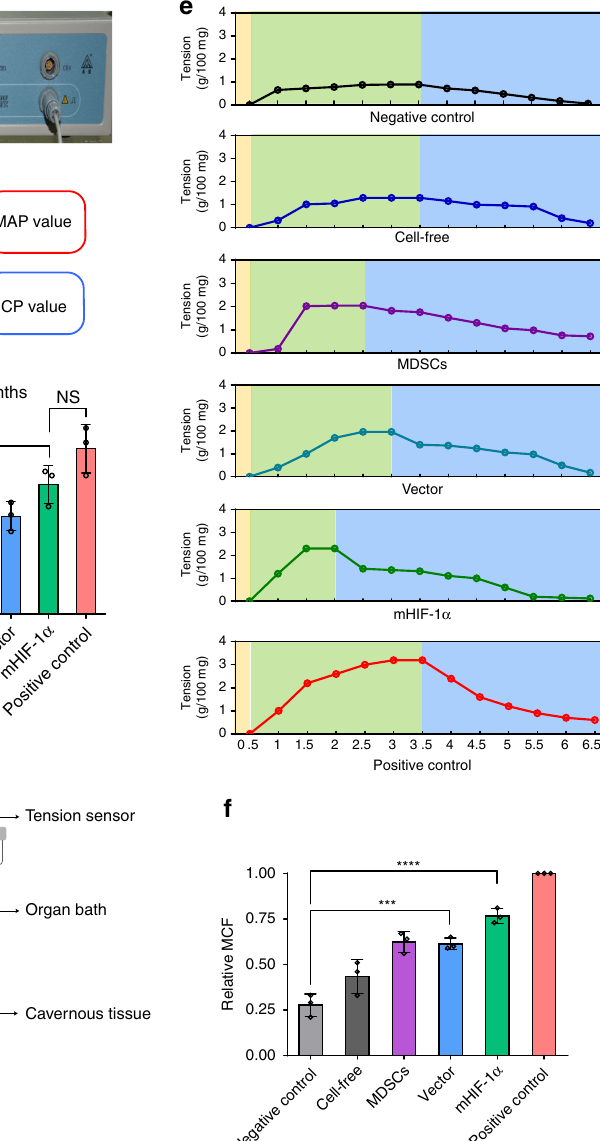
the tunica albuginea 31 . These results indicate that the elevated MAP ratio (close to that of the normal corporal tissue) for